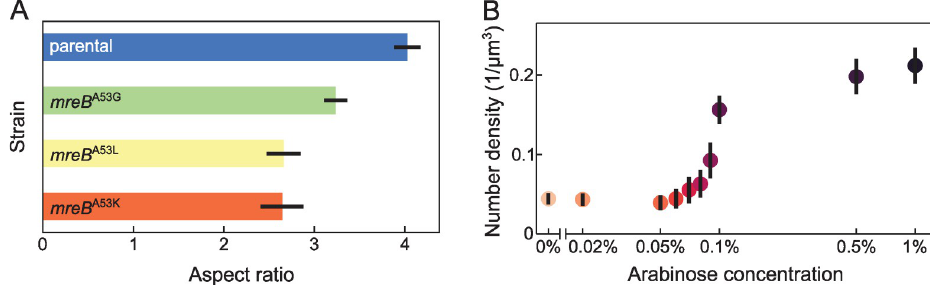
Fig 2. Cell aspect ratio and cell–cell adhesion can be precisely controlled in mutant strains. ( A ) Using different V . cholerae strains, the cell aspect ratio can be experimentally varied. Measurements were performed for n = 30 biofilms, including strains with point mutations in the mreB gene. Bar height corresponds to means; error bars indicate standard deviations. ( B ) Through additional mutations, the local number density can be varied experimentally, independent from the cell aspect ratio. Biofilms grown in the presence of different arabinose concentrations ( n = 12 biofilms for each arabinose concentration) exhibit an increasing local number density with increasing arabinose concentration. Measurements were performed and averaged for Δ rbmA strains with either the wild-type mreB , mreB A53K , mreB A53L , or mreB A53G , harboring a plasmid with an arabinose-inducible rbmA expression construct (P BAD - rbmA ). Data points are colored according to the arabinose concentration; error bars indicate standard deviations. Source data are available at DOI: